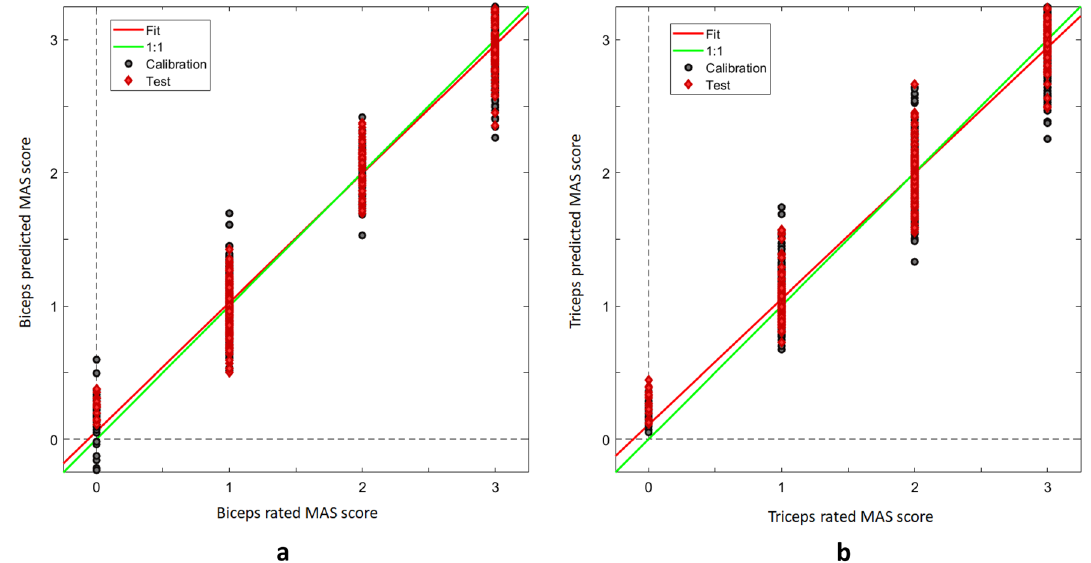
Figure 6. PLS regressions for the clinical measures of hypertonia from reflectance spectra. (a) MAS scores in the biceps and (b)